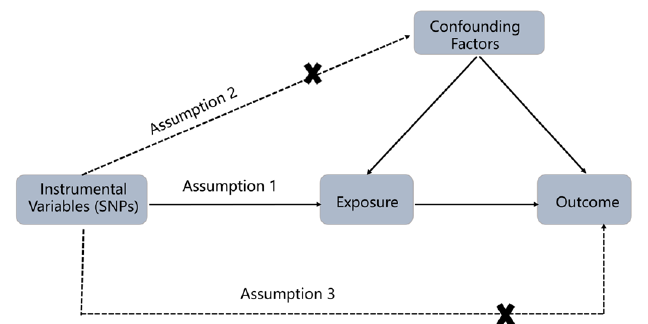
Figure 1. The schematic diagram of Mendelian Randomization (MR). Three assumptions should be met: Assumption 1: The SNPs should be closely related to exposures; Assumption 2: The SNPs selected should be independent of confounders; Assumption 3: The SNPs should affect results only through exposure but not the direct correlation. (SNPs: single nucleotide